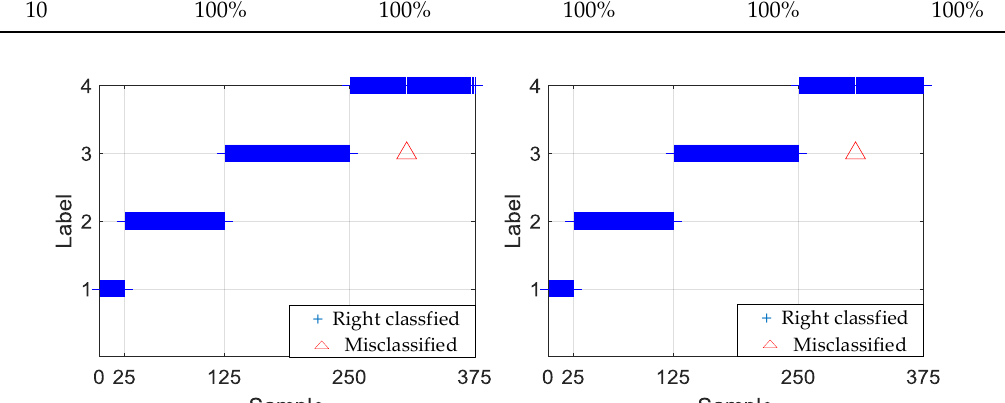
Figure 8. Identification results of experiments 2 and 6.